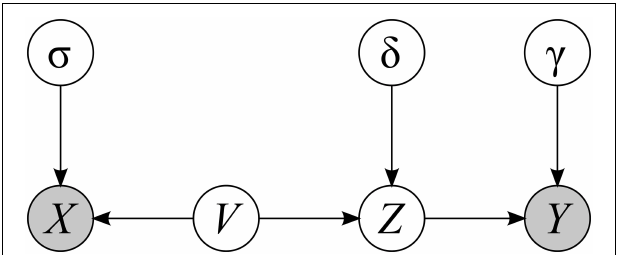
FIGURE 1 | Relation between random variables discussed. Arrows indicate possible causal impact. White circles denote latent variables and gray circles denote observable variables. Lowercase Greek letters denote random noise.